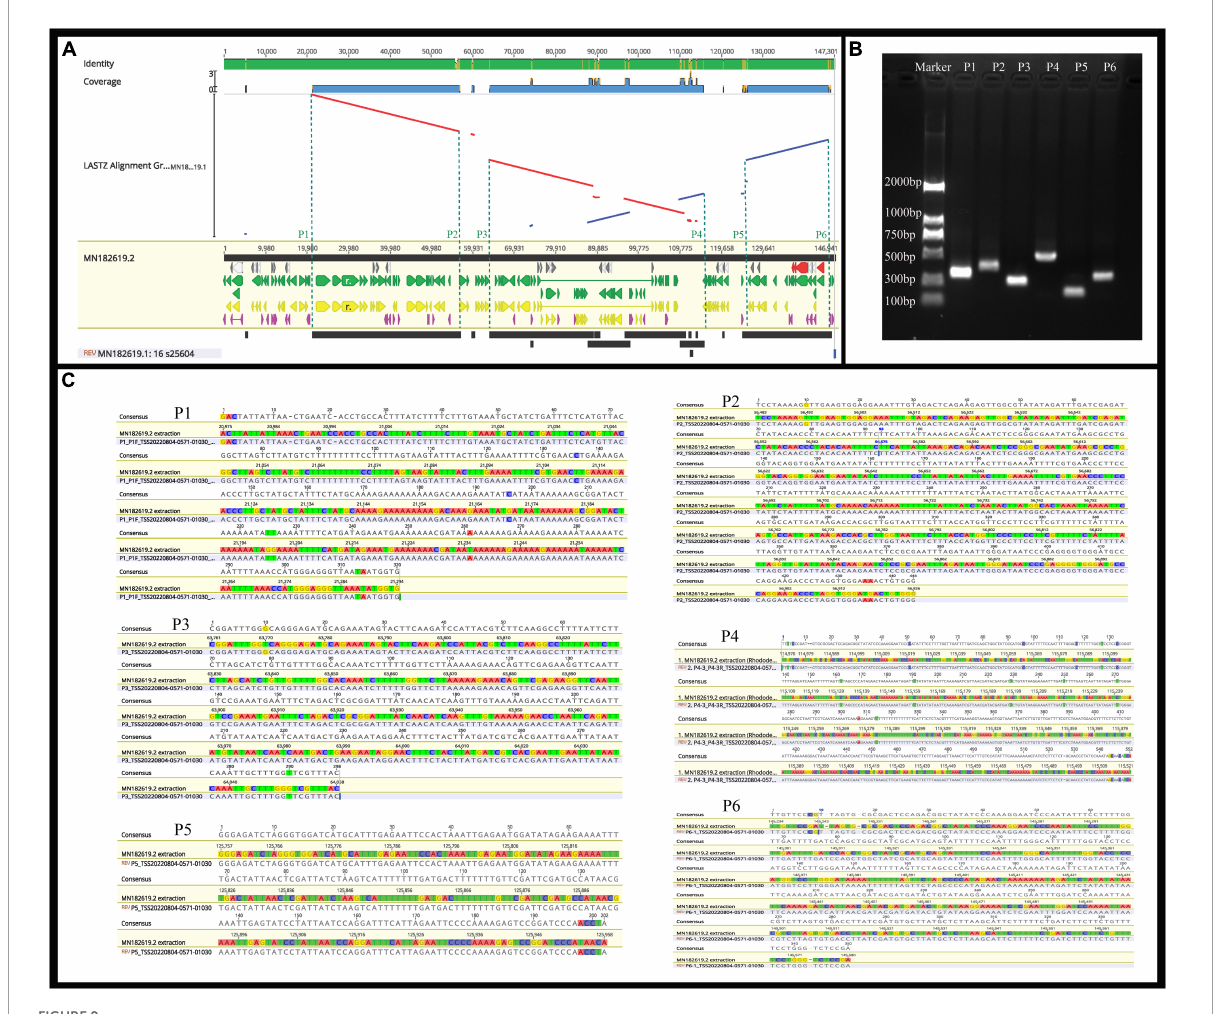
FIGURE9 The identified of the results between MN182619.1 and MN182619.2. (A) Complete chloroplast genome collinear alignment compared between MN182619.1 and MN182619.2 of Rhododendron × pulchrum . MN182619.1 as the reference; blue bars represent homologous high-scoring segment pairs in a codirectional orientation, whereas red bars represent reversed pairs. Yellow arrows represent coding sequences, red arrows represent ribosomal RNA genes, purple arrows represent transfer RNA genes, green arrows represent protein-coding genes, and gray arrows represent exonic regions. Black squares represent homology; the larger the number, the larger the area of the black squares, and the more closely related species have homologous fragments. Red wireframes are the most conservative regions. The P1 ∼ P6 sites located in 21,232, 56,637, 63,979, 115,230, 125,853, and 145,493 bp position of MN182619.2. (B) PCR products detection. (The P1 ∼ P6 sites located in 21,232, 56,637, 63,979, 115,230, 125,853, and 145,493 bp position of MN182619.2; the expected size of the P1 ∼ P6 are 355, 444, 300, 581, 201, and 348 bp, respectively). (C) Results of PCR compared with plastid genomes fasta (MN182619.2) that assembled with third-generation combined with second-generation sequencing methods. [A ∼ E (P1 ∼ P6): Six broken sites were randomly selected from the result of collinearly aligned (LASTZ) of MN182619.1 and MN182619.2, as shown in Figure 5 . The upper numbers indicate PCR results, the lower numbers indicate the point of plastid genomes fasta that assembled with third-generation combined with second-generation sequencing